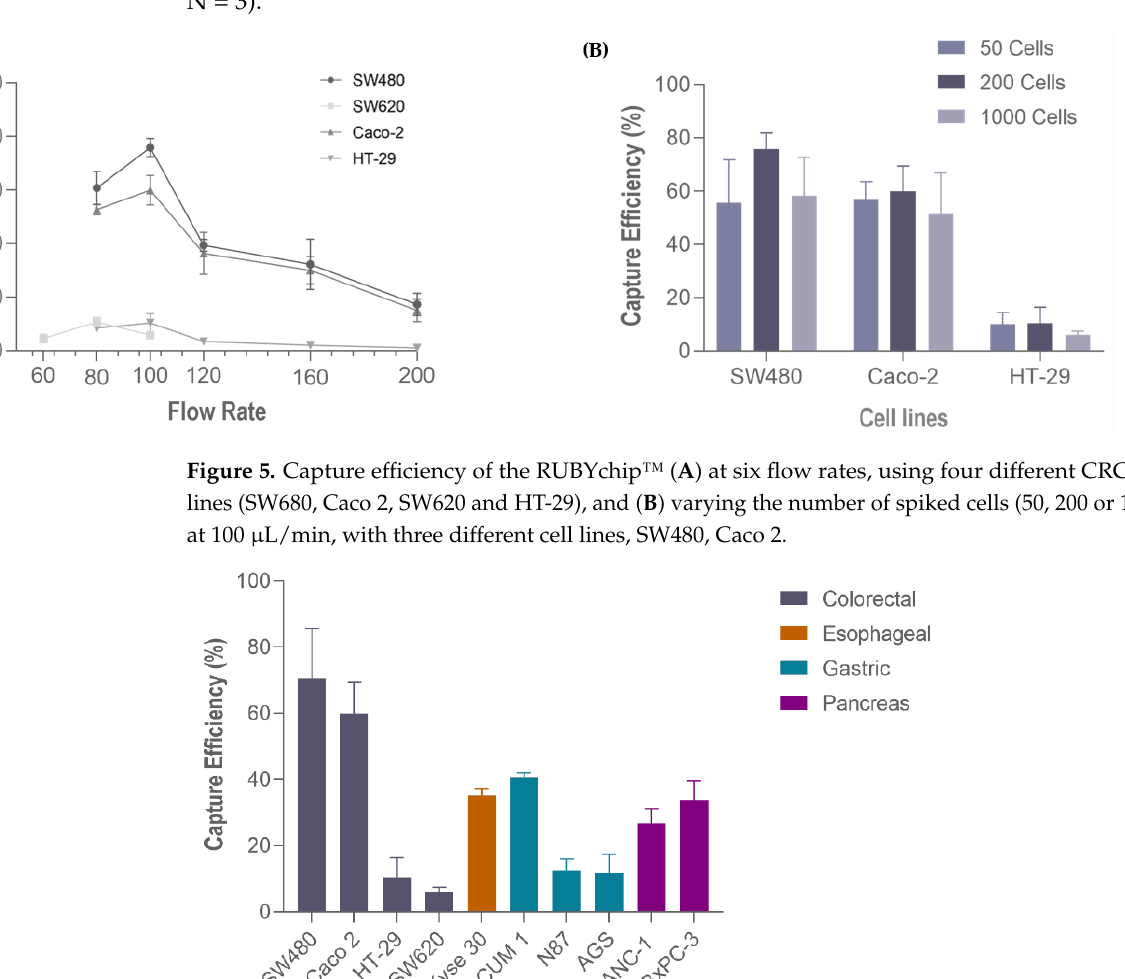
Figure 5. Capture efficiency of the RUBYchip™ ( A ) at six flow rates, using four different CRC cell lines (SW680, Caco 2, SW620 and HT-29), and ( B ) varying the number of spiked cells (50, 200 or 1000) at 100 µL/min, with three different cell lines, SW480, Caco 2.